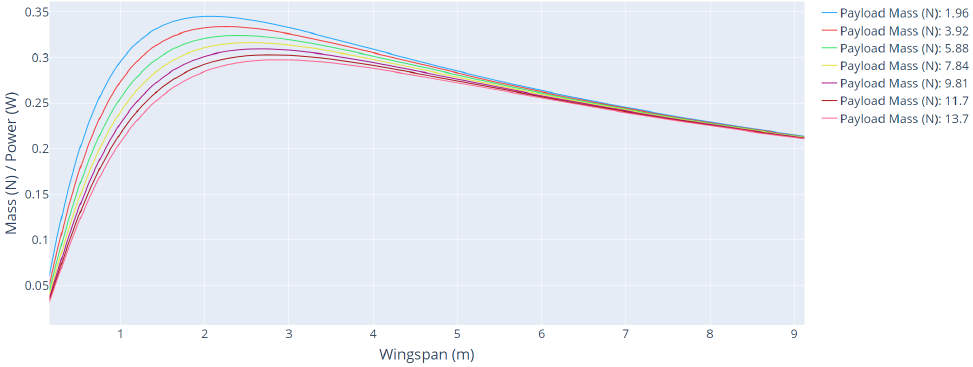
Figure 10. Mass/power ratio as a function of wingspan for different payload mass.